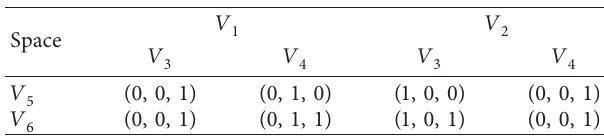
Table 3: The behavioural strategies of three P2P lending partici- pants in each